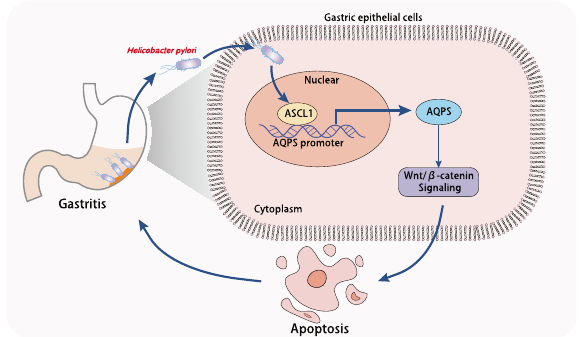
Fig. 7 Molecular mechanisms of H. pylori infection involved in the occurrence of gastritis. H. pylori infection induces AQP5 expression by promoting ASCL1 expression to activate the Wnt/ β -catenin pathway, which led to the in fl ammation and apoptosis of GECs in fi ndings provided novel insights for the development of therapeutic strategies for inhibiting the occurrence of gastritis induced by H. pylori infection. However, the translation of the fi nding into clinical scenario may be limited by the lack of veri fi cation of the expression and distribution of AQP5 and ASCL1 in clinical samples of gastritis and IM, which should be further studied in future investigations.